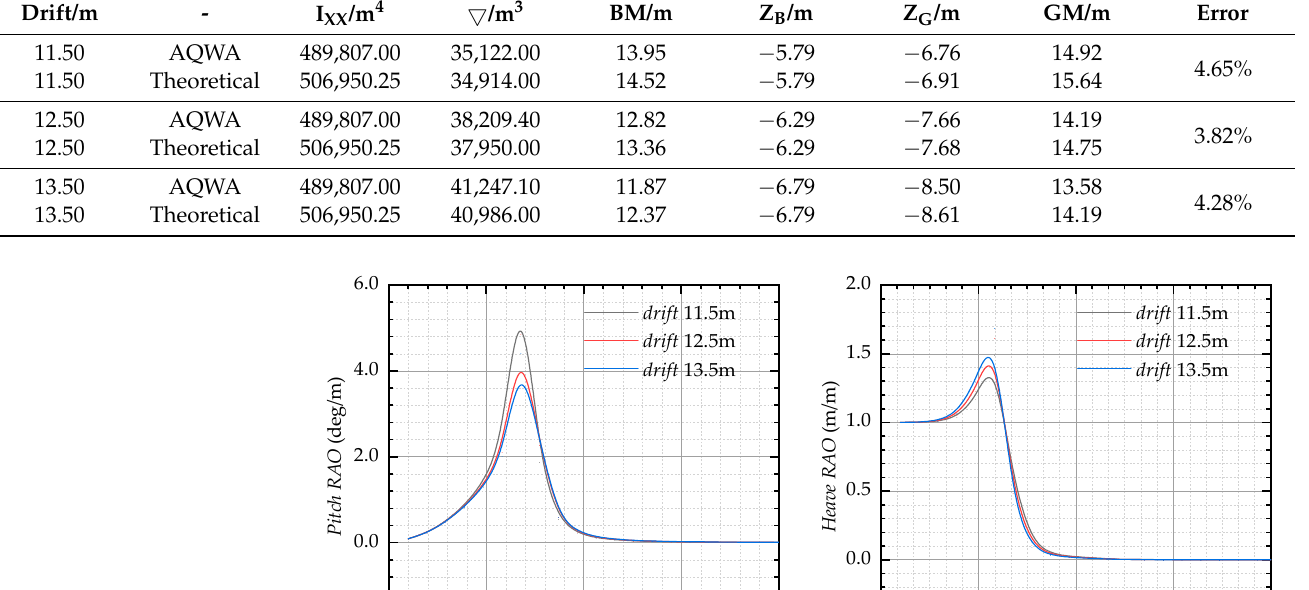
Figure 7. Pitch and Heave RAOs.